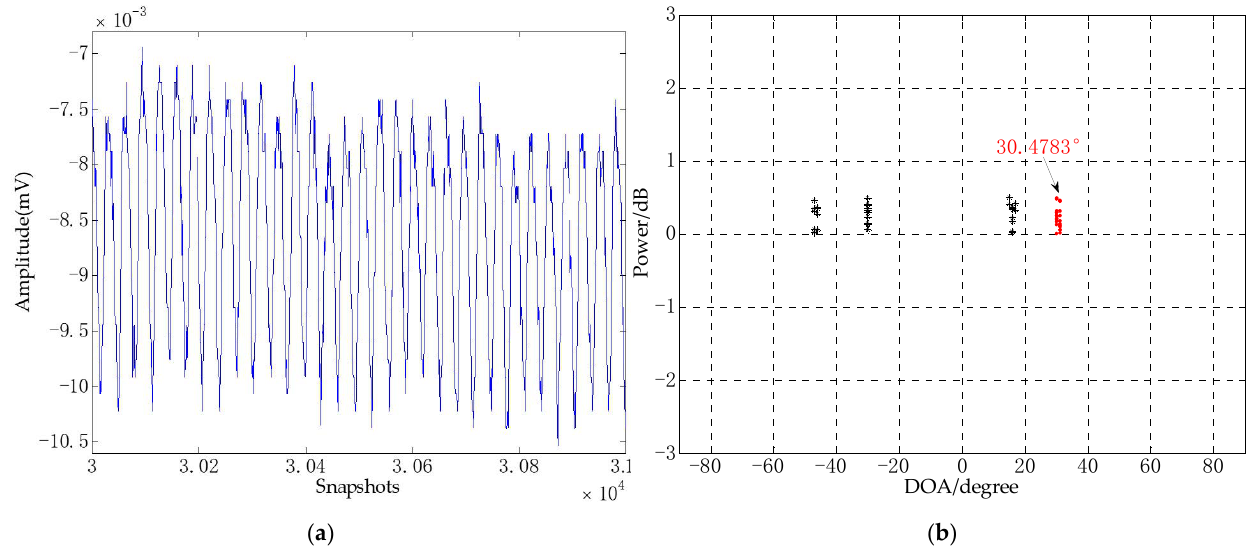
Figure 19. ( a ) The part of original signal and ( b ) DOA estimation.